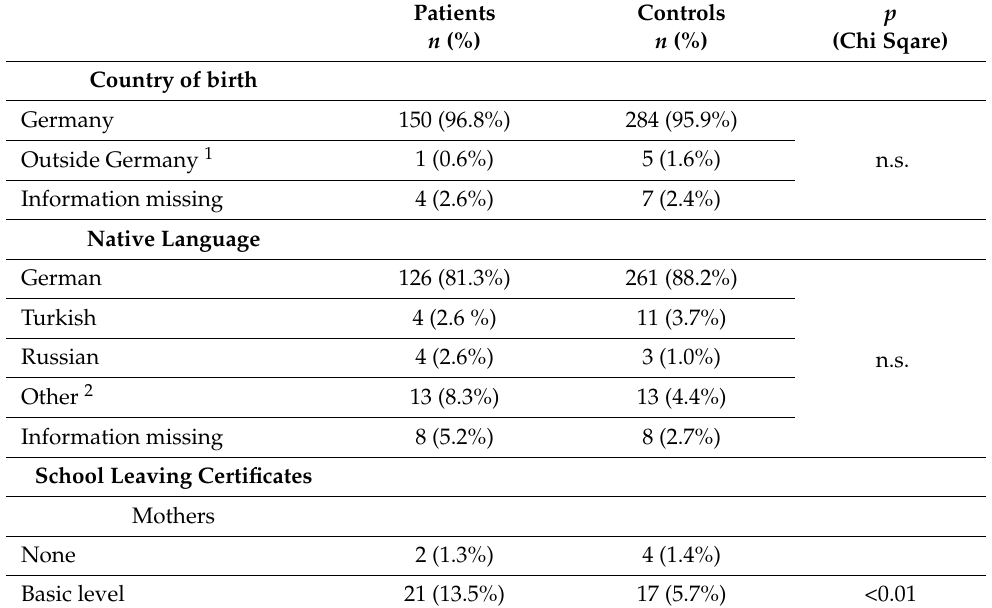
Table 2. Socioeconomic and cultural background of study